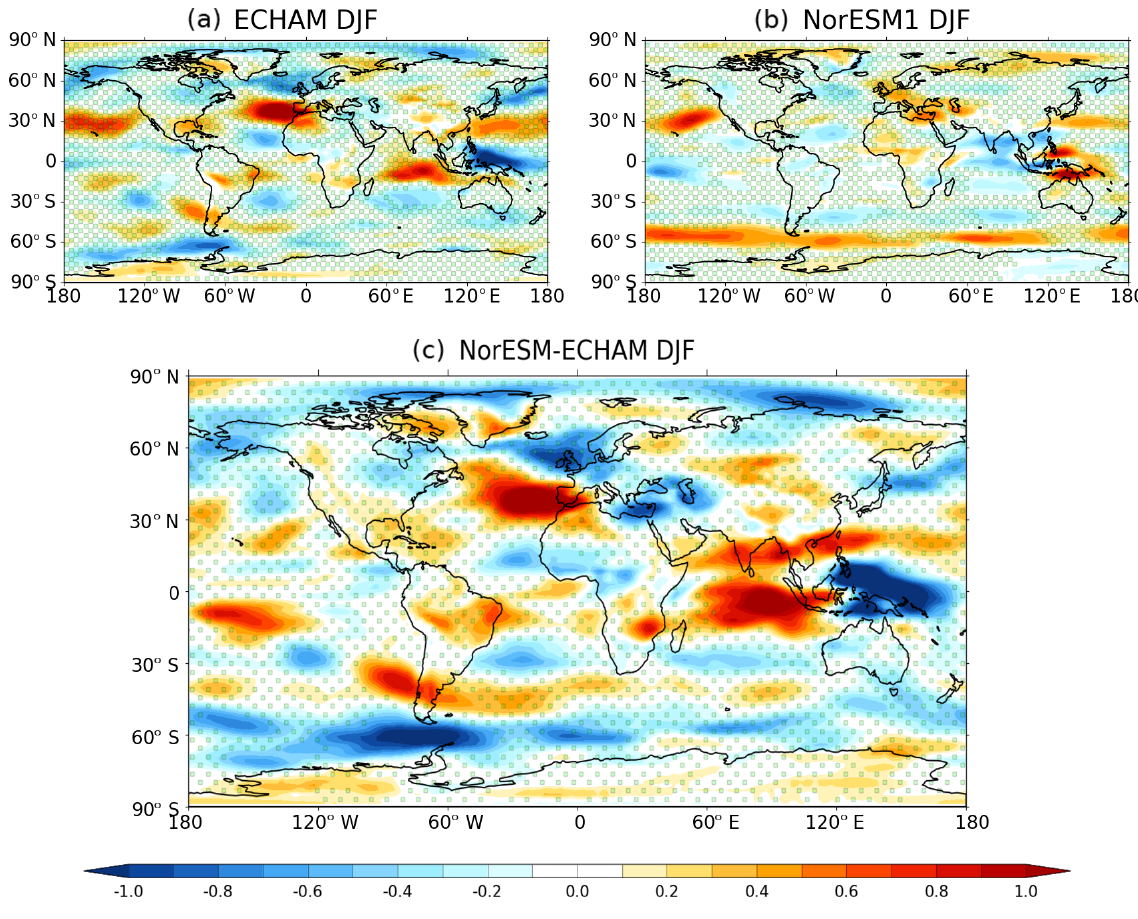
Figure C5. Lower tropospheric (850hPa) zonal wind response to adding MACv2-SP anthropogenic aerosols for Northern Hemi- sphere winter. The green dots represent the area where anthro- pogenic aerosols do not have a statistically significant impact at the p < 0 . 05 level (in panel c ) or where the difference between the models is not statistically significant (in panels a and b ). The units are in ms − 1